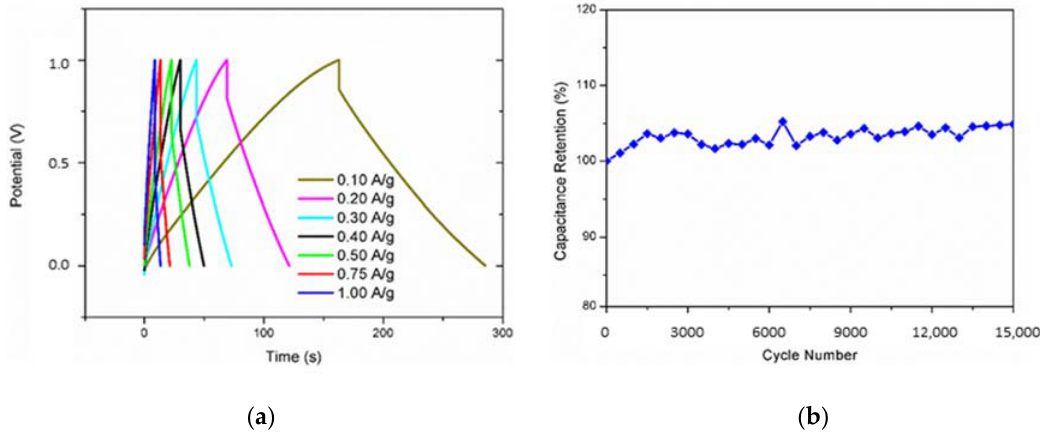
Figure 5. ( a ) charge–discharge curves at different current density and ( b ) evolution of the capacitance retention in function of the cycle number for the RGO/Ruthenium active species